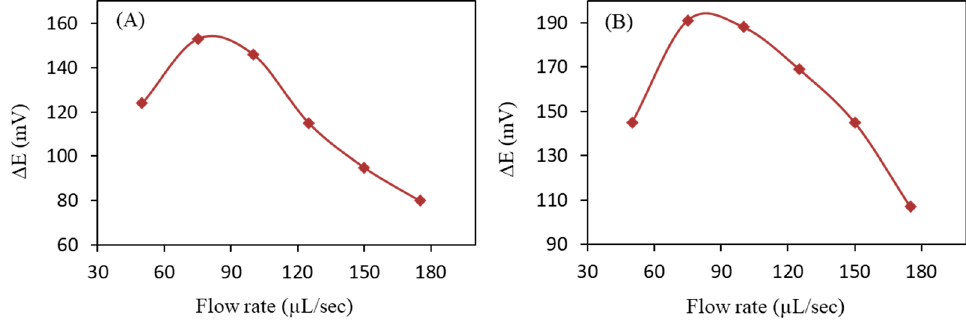
Figure 7. E ff ect of KIO 3 fl ow rate (µL/s) on potential signal (shown as average, n = 3) for DC-DEP ( A ) and SW-DEP ( B ) methods. and SW-DEP ( B )